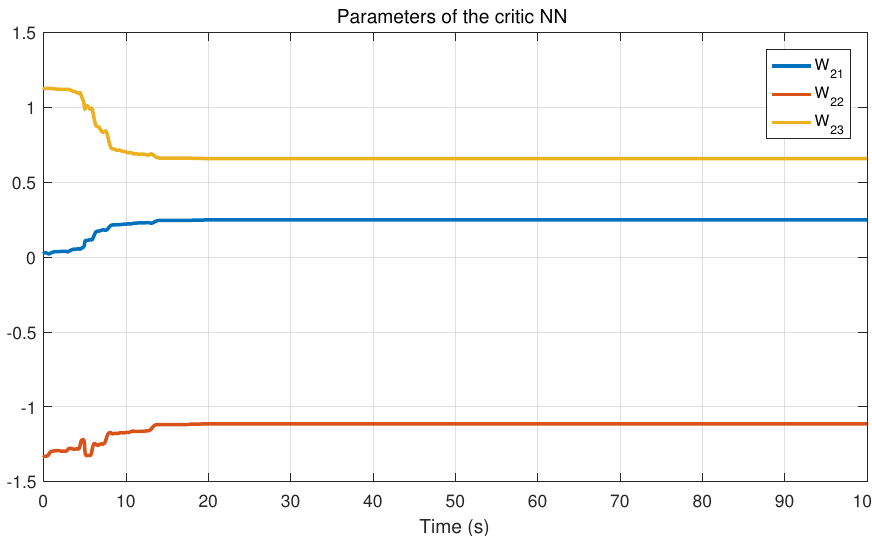
Figure 9. Evolution of the critic estimates for player 2.